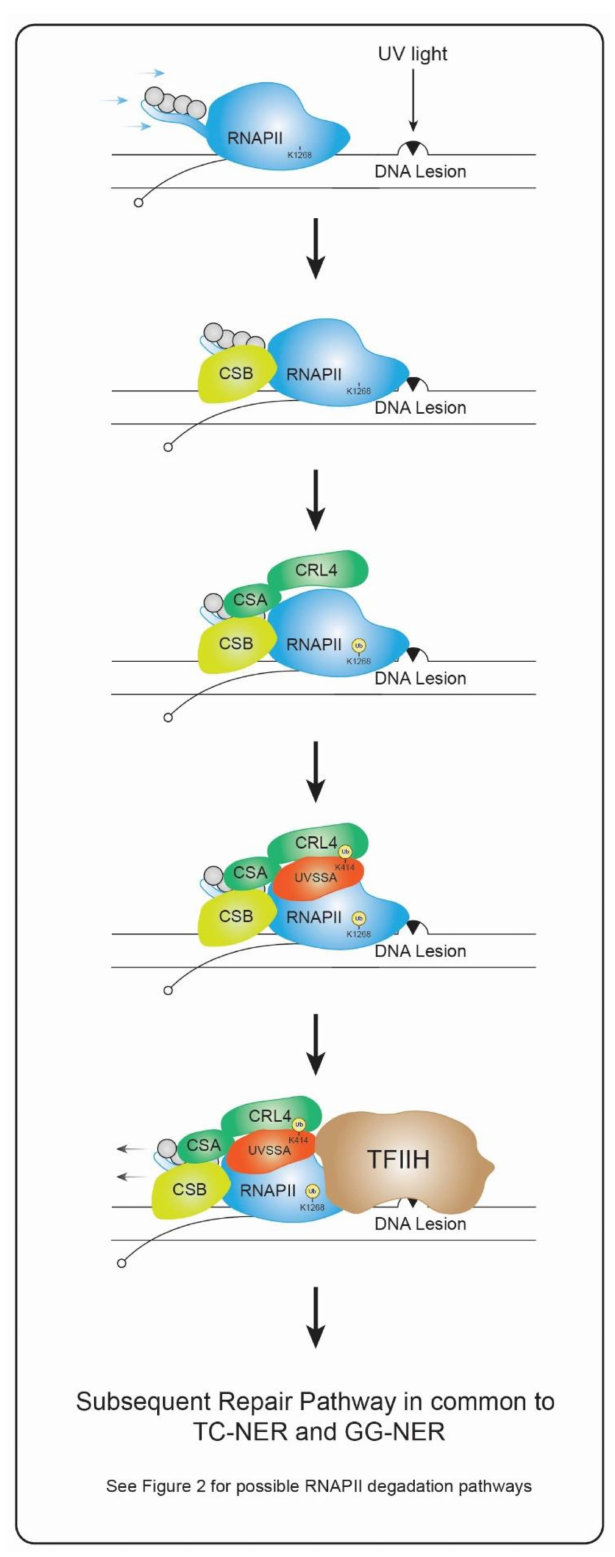
Figure 1. Model of Transcription-Coupled recognition of DNA damage. Stalling of RNAPII in- duces the recruitment of CSB and the E3 ligase complex CRL4CSA, which stands as the major contributor to RPB1 K1268 ubiquitylation upon UV, although other E3 ligases might be involved (see references [8,28,29]). Once RPB1 is ubiquitylated, UVSSA is recruited and ubiquitylated in its K414 residue, which facilitates TFIIH binding to the stalled complex. In order to expose the